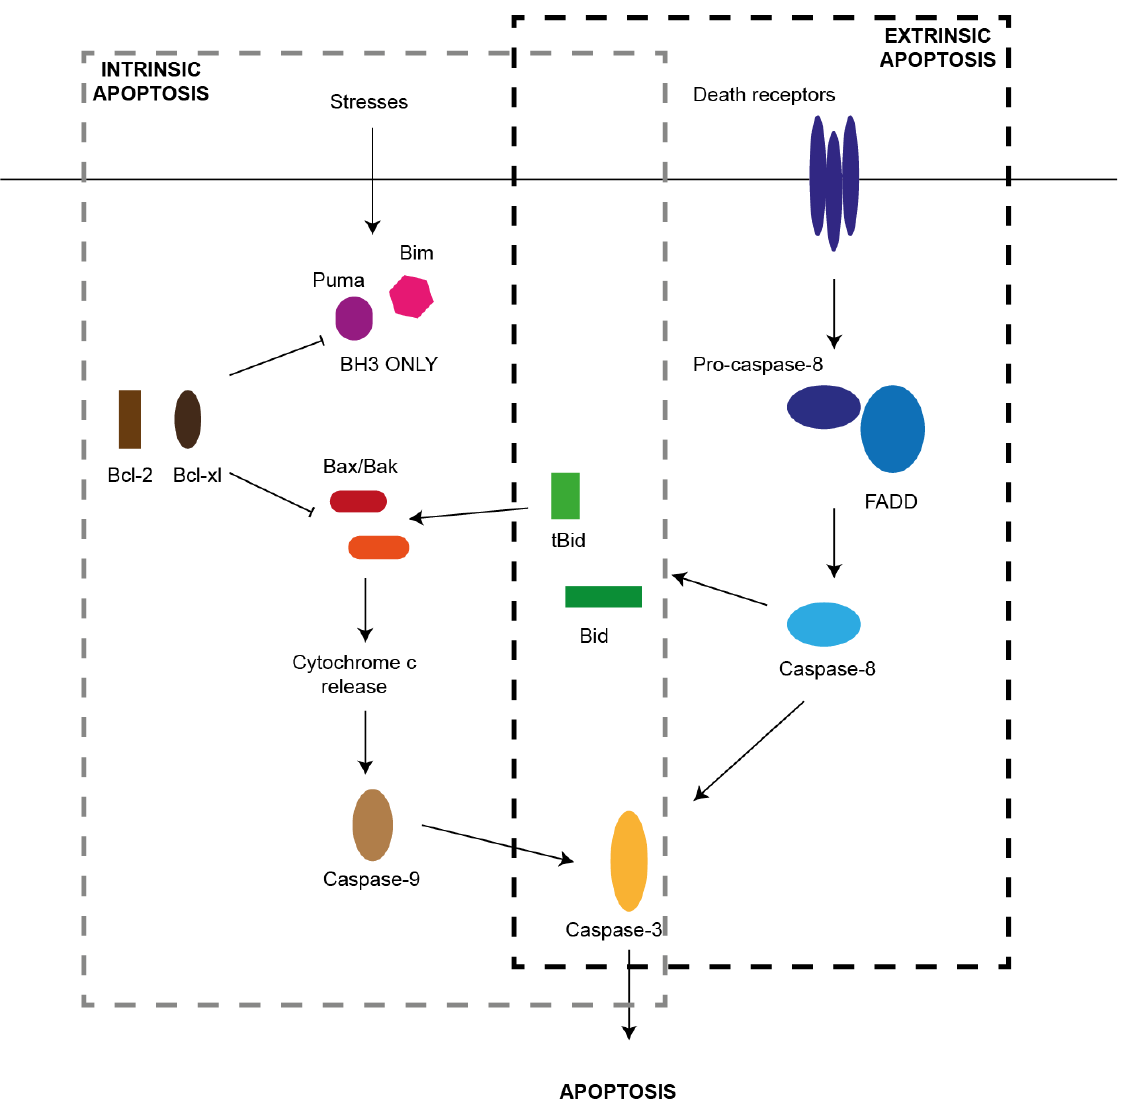
The two pathways of apoptosis can cross-talk through caspase-8 dependent cleavage of Bid to its truncated form (t-Bid). t-Bid can inhibit pro-survival Bcl-2 proteins and activate Bax and Bak [9–11]. Figure 1. The two pathways of apoptosis. There are two major pathways of apoptosis in mammalian cells, the intrinsic and extrinsic pathways. The intrinsic pathway is activated by cellular stresses (such as high glucose concentrations or growth factor deprivation) and results in activation of the BH3-only members of the Bcl-2 family (such as Bim and Puma) that initiate apoptosis signaling by binding to the Bcl-2-like pro-survival proteins (including Bcl-2 and Bcl-xL) and release of Bax and/or Bak to promote loss of mitochondrial outer membrane potential, cytochrome c release and activation of caspase-9, caspase-3 and apoptosis. The extrinsic pathway is initiated by activation of death receptors, such as Fas, that have an intracellular death domain. This results in formation of a death-inducing signaling complex in which the initiator caspase, caspase-8 is activated by its adaptor FAS-associated death domain (FADD). This results in activation of the caspase cascade and apoptosis. The BH3-only protein Bid is essential for death receptor-mediated apoptosis in beta cells, thereby providing cross-talk between the two apoptotic